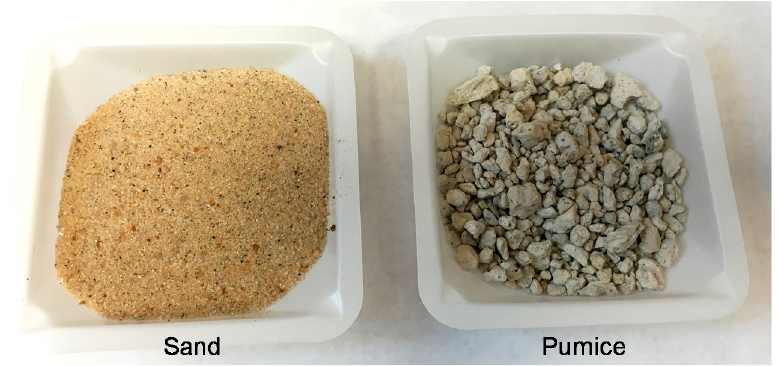
Figure 1. Geomedia tested in this study.